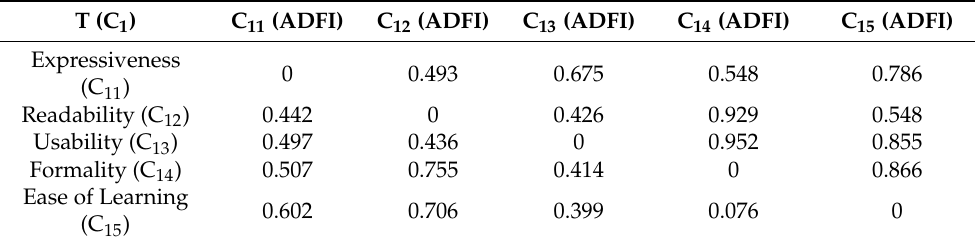
Table 6. Average direct fuzzy influence matrix T between Efficiency (C 1 )